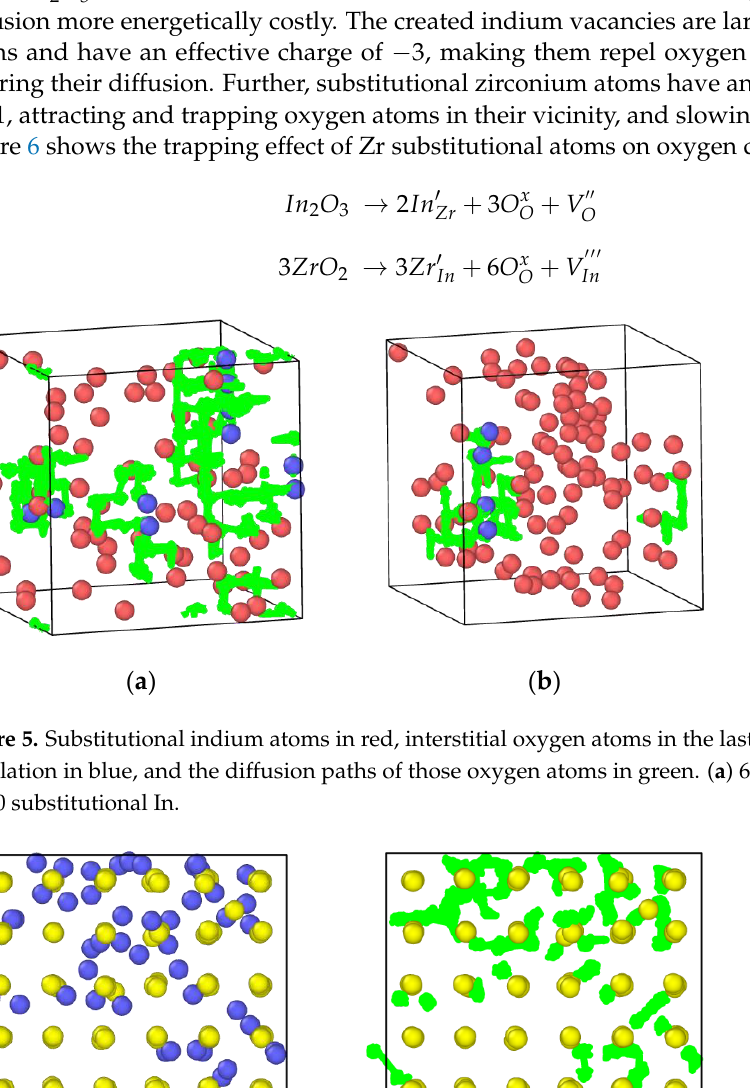
Table 7. Anion Frenkel defects formation percentage at 850 °C in defective crystals.